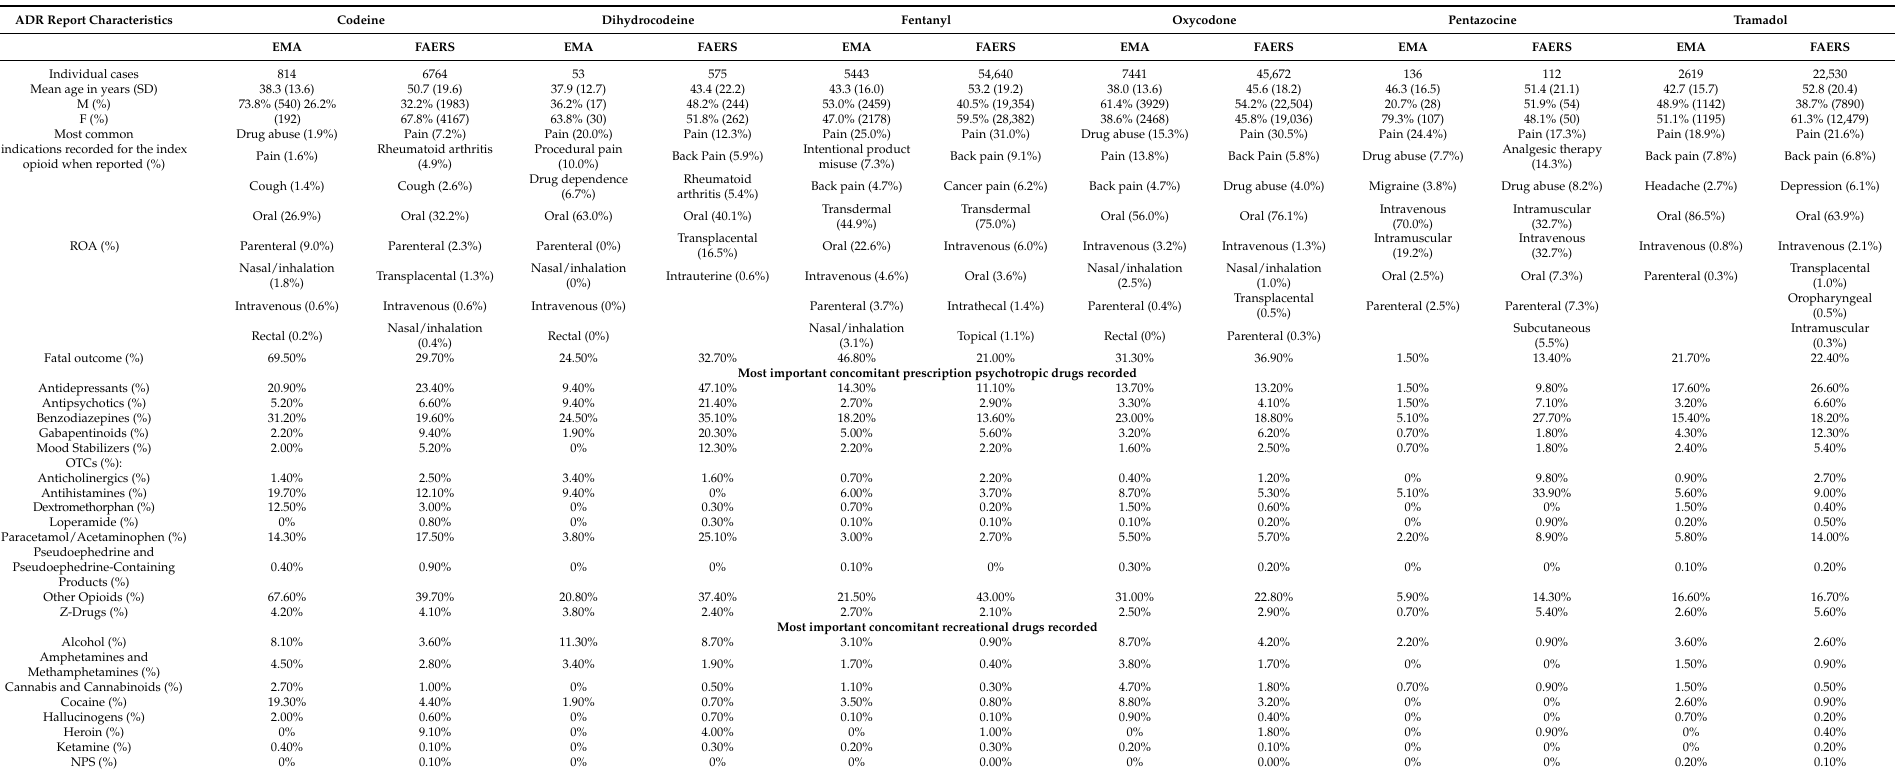
Table 1. Analysis of opioid-related adverse drug reaction reports recorded in the European Medicines Agency (EMA) EudraVigilance (EV) dataset and the Food and Drug Administration (FDA) Adverse Event Reporting